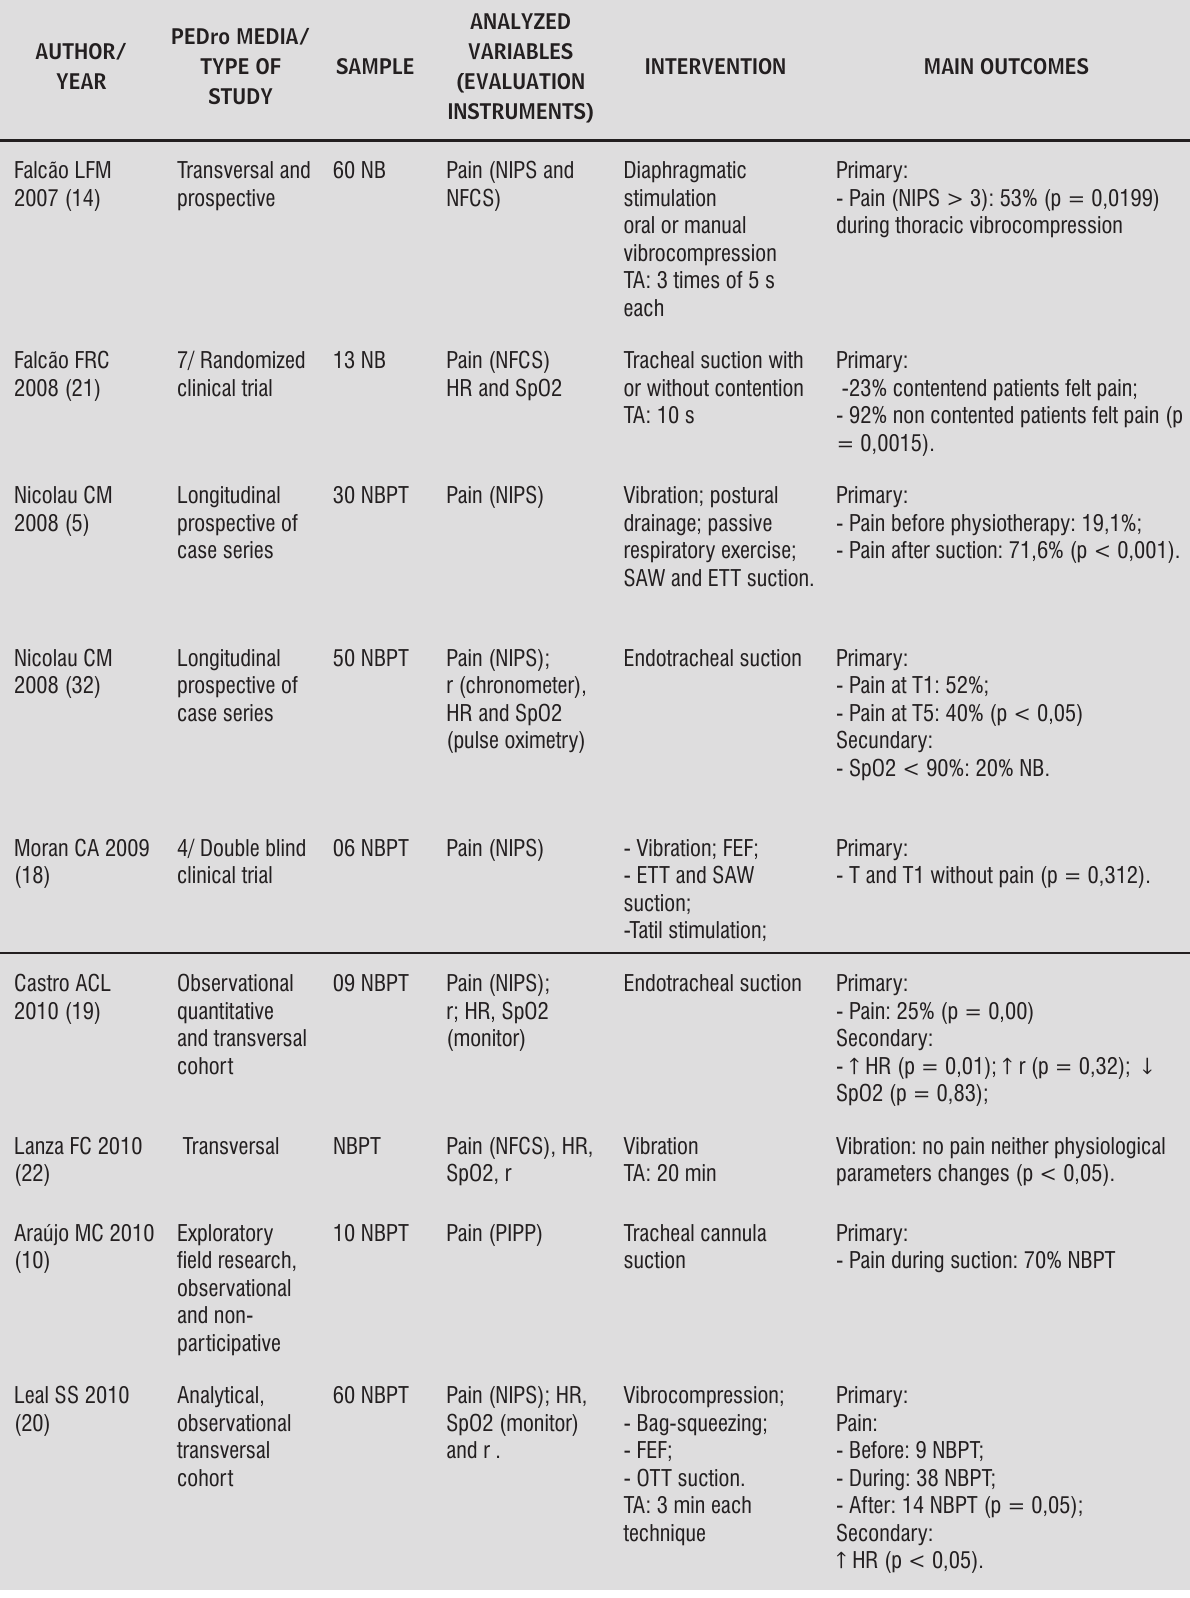
Table 1 - Main data from selected